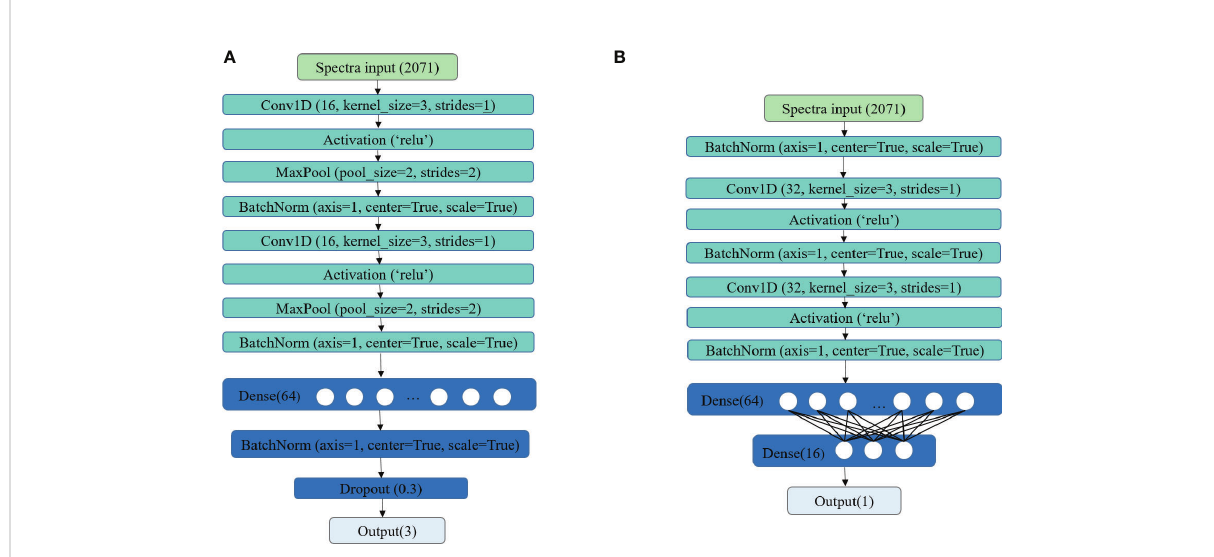
FIGURE 3 The CNN structure for classi fi cation model (A) and regression model (B)